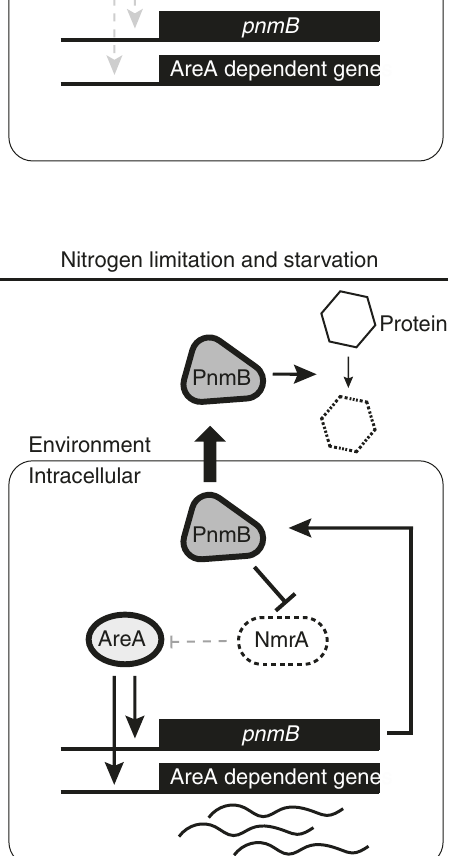
Fig. 5 Regulatory model of AreA-NmrA-PnmB loop. In nitrogen-suf fi cient conditions, NmrA levels are high, while AreA levels are low. NmrA represses AreA-mediated activation of pnmB and nitrogen metabolism genes. In nitrogen-starvation conditions, AreA expression and activity is increased while NmrA levels are decreased. pnmB expression is activated by AreA. The increased PnmB levels further accelerate the decrease of NmrA levels. AreA, PnmB, and NmrA form a positive regulatory loop to enhance AreA activity and nitrogen response rate. At the same time, PnmB was also secreted outside the cell to facilitate nutrient